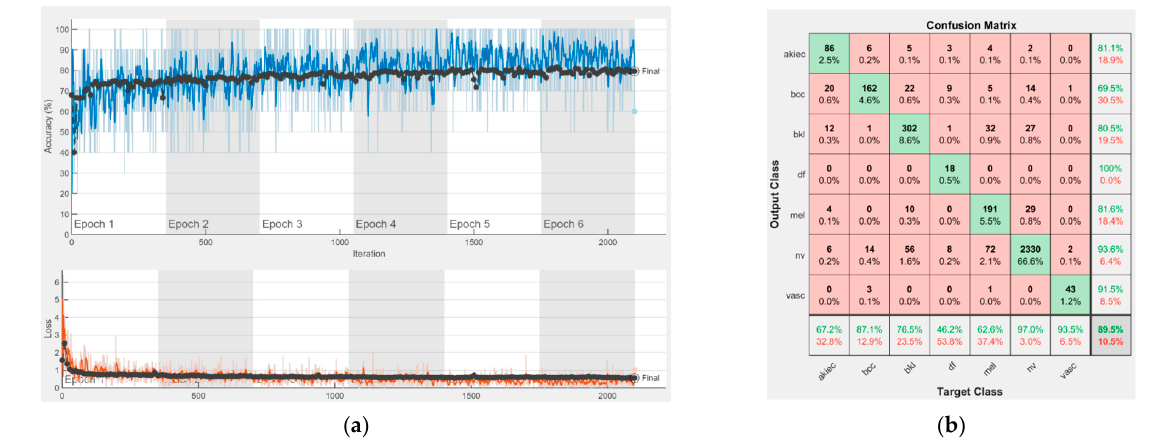
Figure 8. Results using AlexNet. ( a ) Accuracy and loss, ( b ) Confusion matrix.